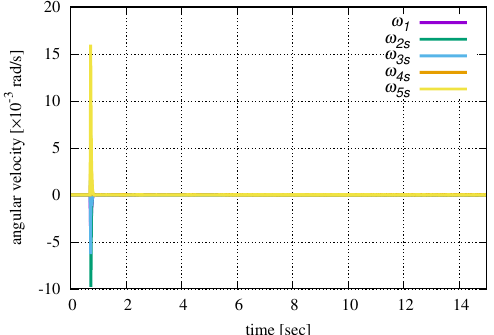
Figure 35. Case 3: Time variation of the angular velocities.